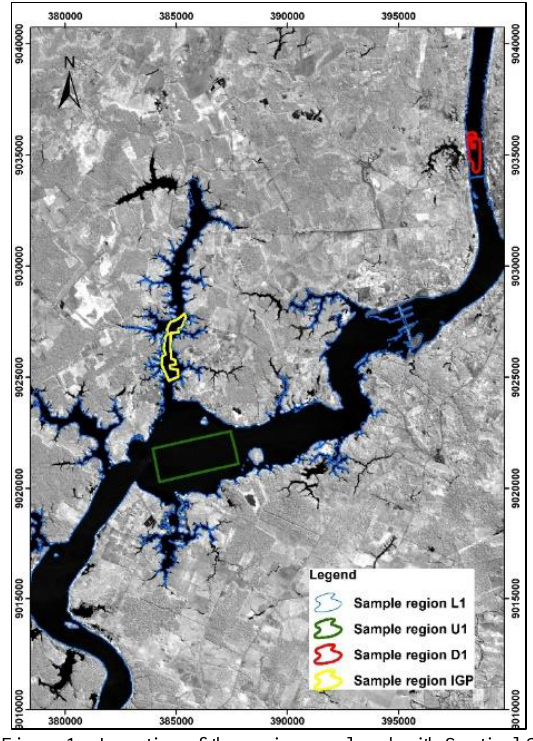
Figure 1 – Location of the regions analysed with